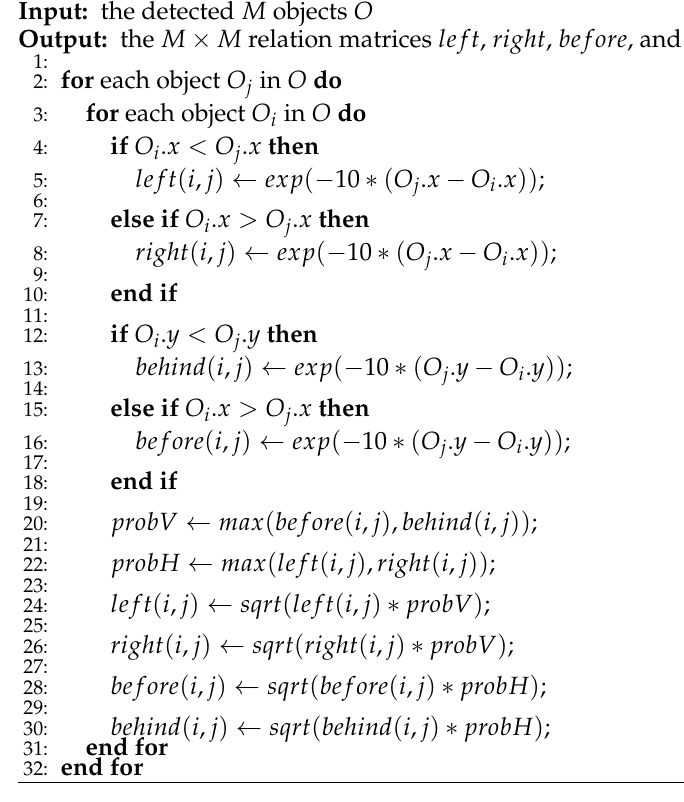
Algorithm 2 Algorithm of Calculating the Group-based